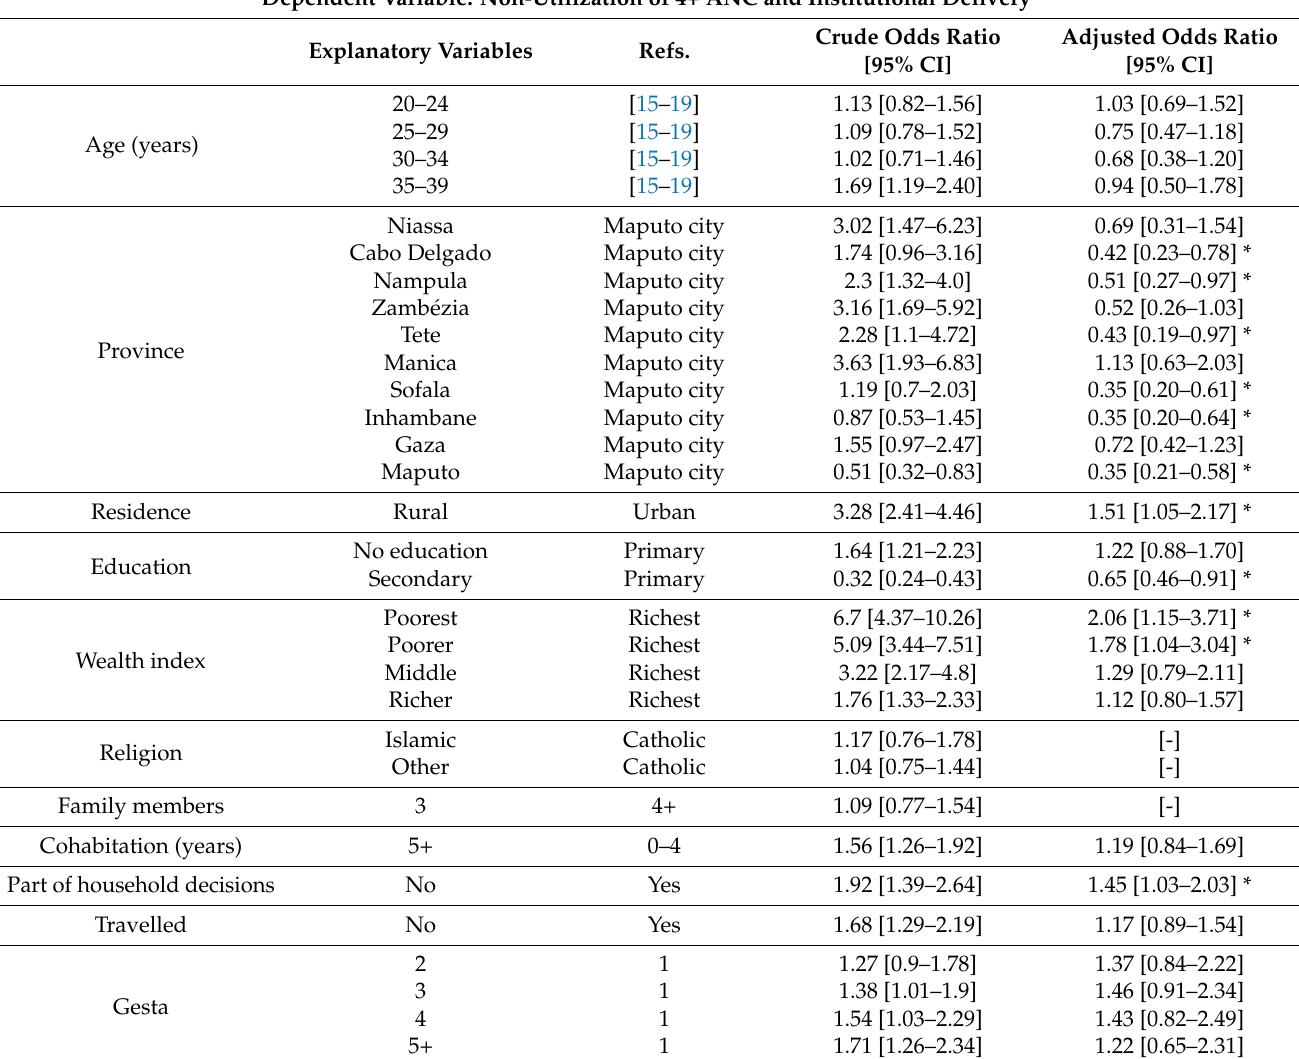
Table 2. Factors associated with non-utilization of maternity health care